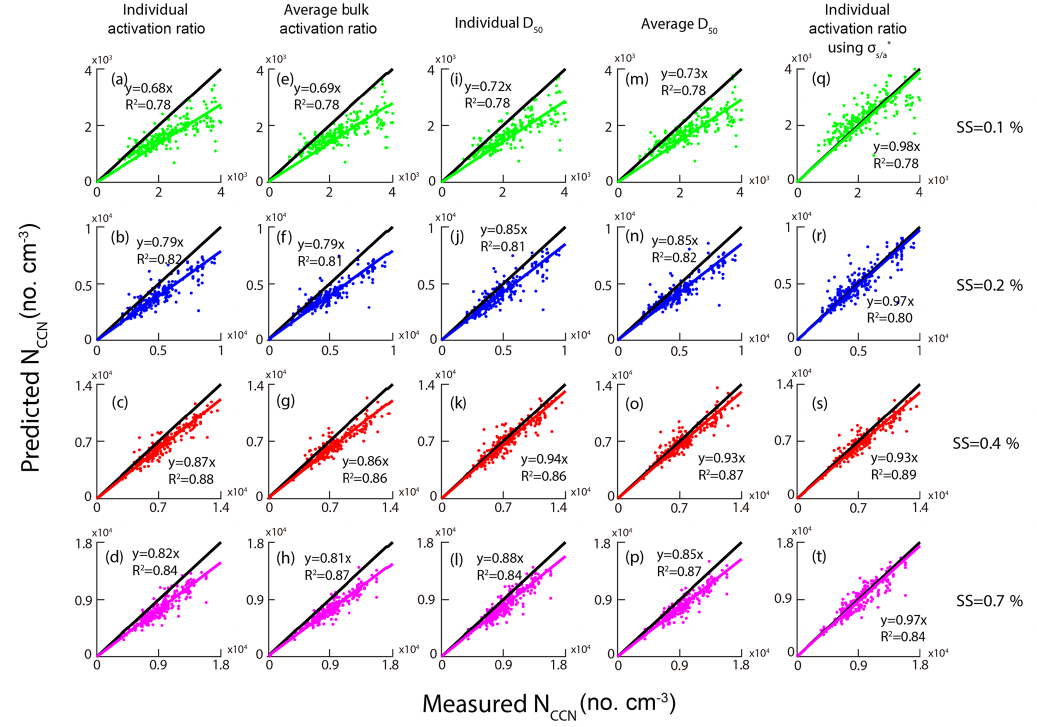
Figure 10. The relationship between measured N CCN and predicted N CCN based on schemes 1, 2, 3, 4, and 5. The black lines represent 1 : 1